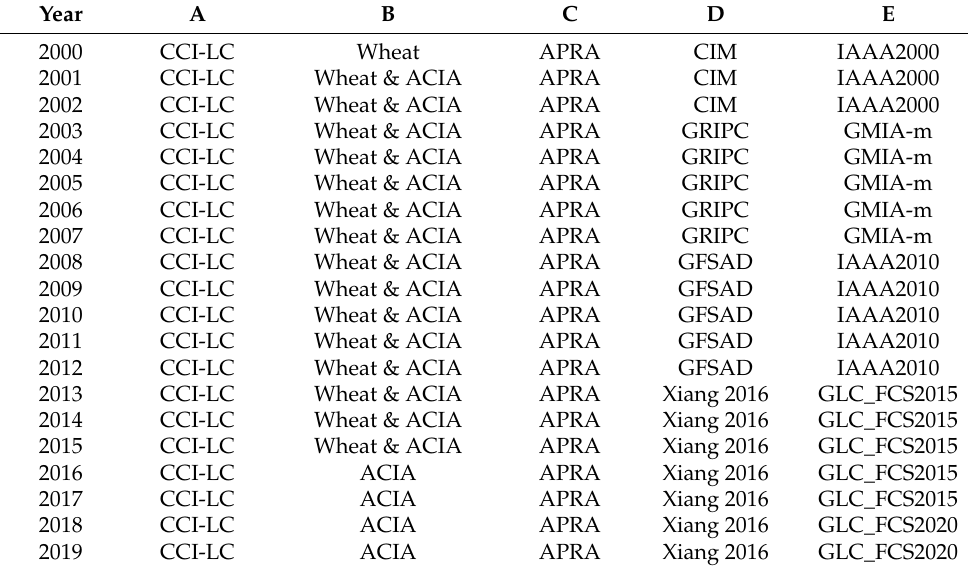
Table 2. Input data applied for each year.